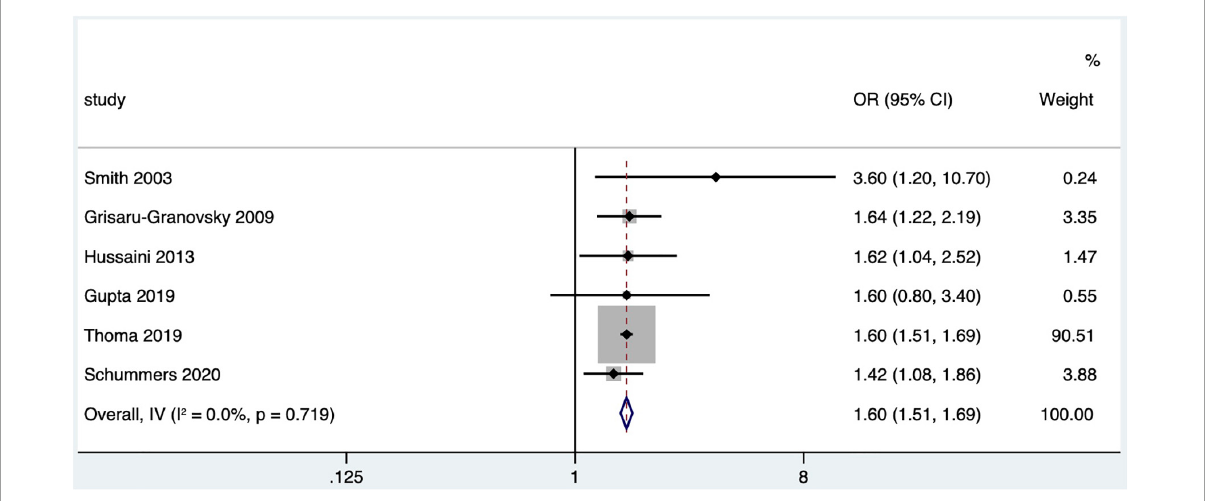
FIGURE6 Meta-analysis forest map of the influence of short IPI on offspring death.